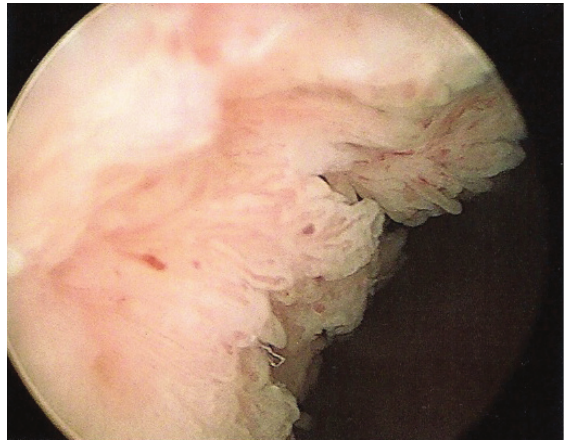
tissue.Figure 2. The bland appearance of the tumour at the bladder neck at his initial